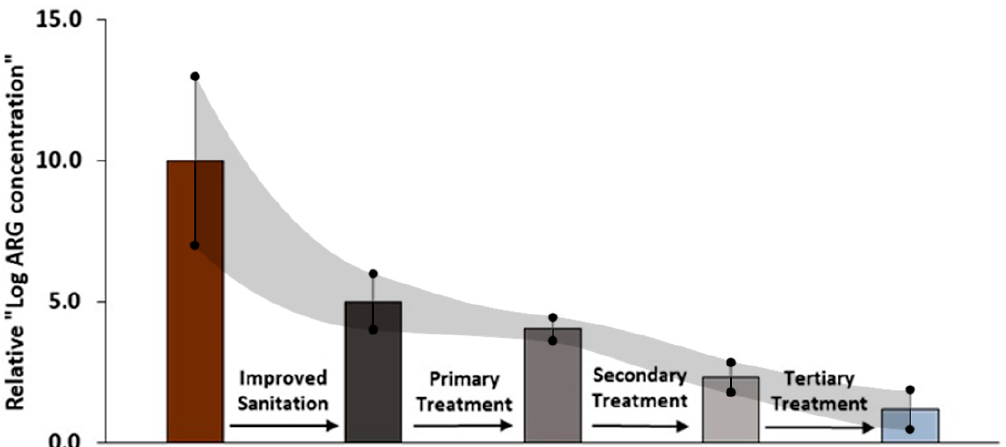
Figure 2. Relative incremental reductions in antibiotic resistance gene (ARG) concentrations as a function of different AR mitigation interventions (see Figure 1). Reductions are baselined to an initial ARG concentration of (log 10) ARG copies/unit volume in fecal matter, which is the brown bar. Each step reduction is based on mean ARG removal data from nine studies on field-scale systems [42–50]. Sample numbers: n = 5 for fecal matter to improved sanitation; n = 8 for improved sanitation to primary treatment; n = 11 for primary to secondary treatment; n = 15 for secondary to tertiary treatment. Error bars refer to standard errors of data from the studies and shaded areas show ranges.